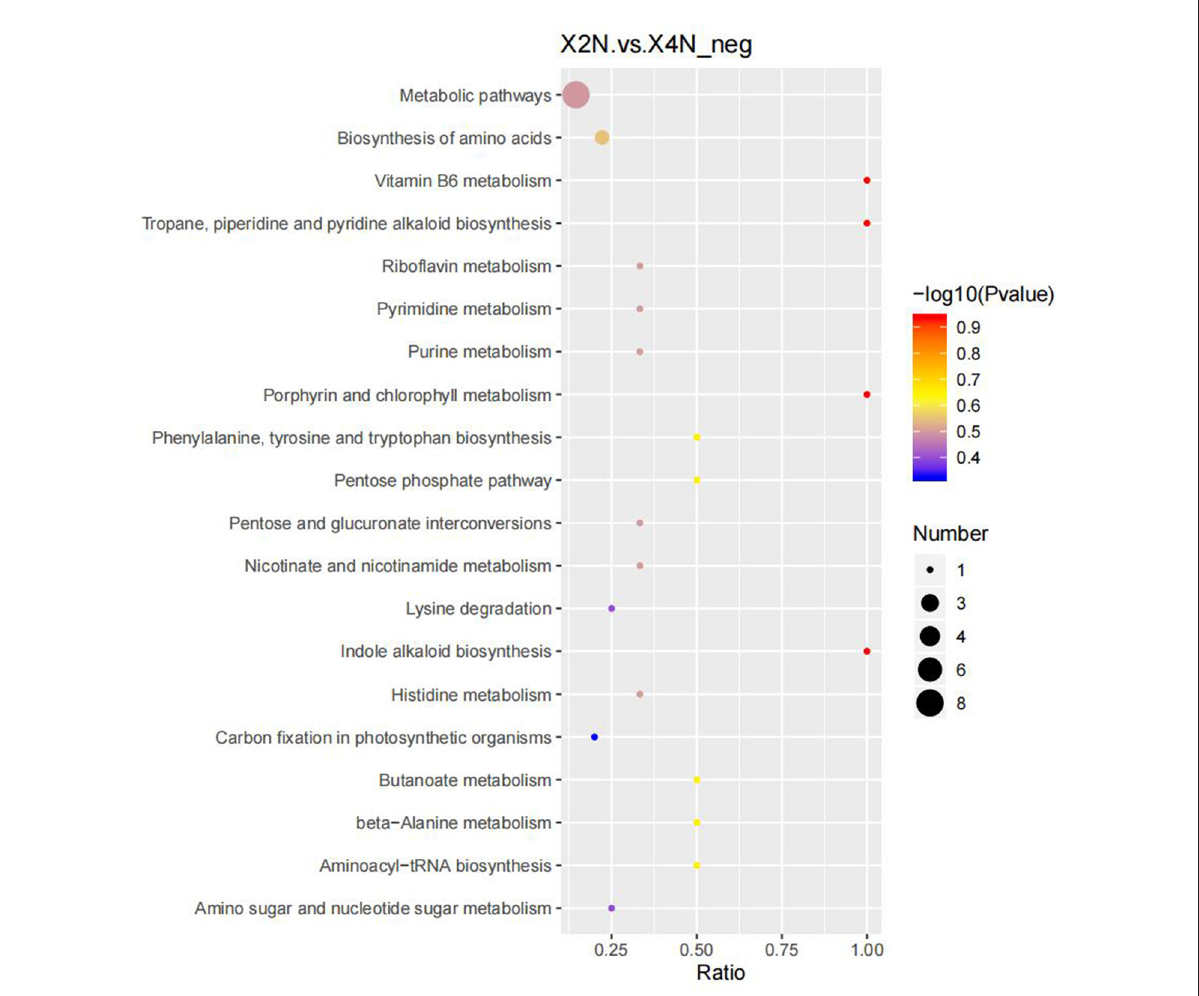
FIGURE9 Scatter plot of 20 KEGG pathways between diploids and autotetraploids of Pisang Berlin of the differentially accumulated metabolites enrichment analysis. The degree of enrichment is shown by ratio, P-value, and the number of metabolites enriched in each pathway. X2N represented diploids of Pisang Berlin; X4N represented autotetraploid of Pisang